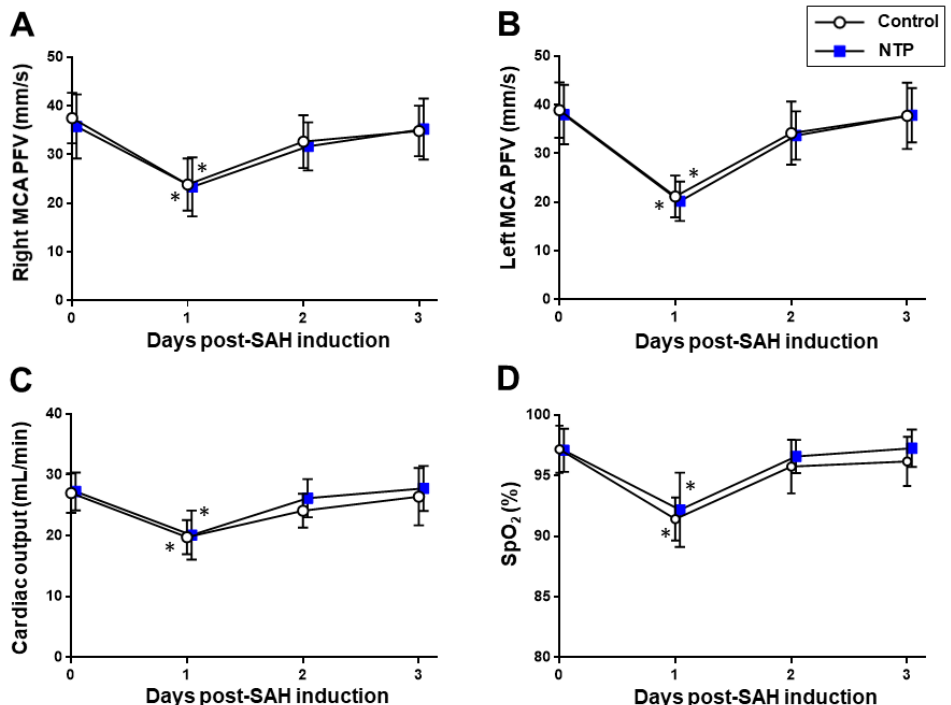
Figure 4. Time–course changes in the acute phase after SAH induction in the control and neurotropin groups. Peak systolic flow velocity (PFV) of the right ( A ) and left ( B ) middle cerebral arteries (MCA). Cardiac output (CO) ( C ). Oxygen saturation (SpO 2 ) ( D ). * p < 0.05 vs. baseline; two-way ANOVA with a post hoc analysis (Bonferroni–Dunn’s test). NTP, neurotropin.